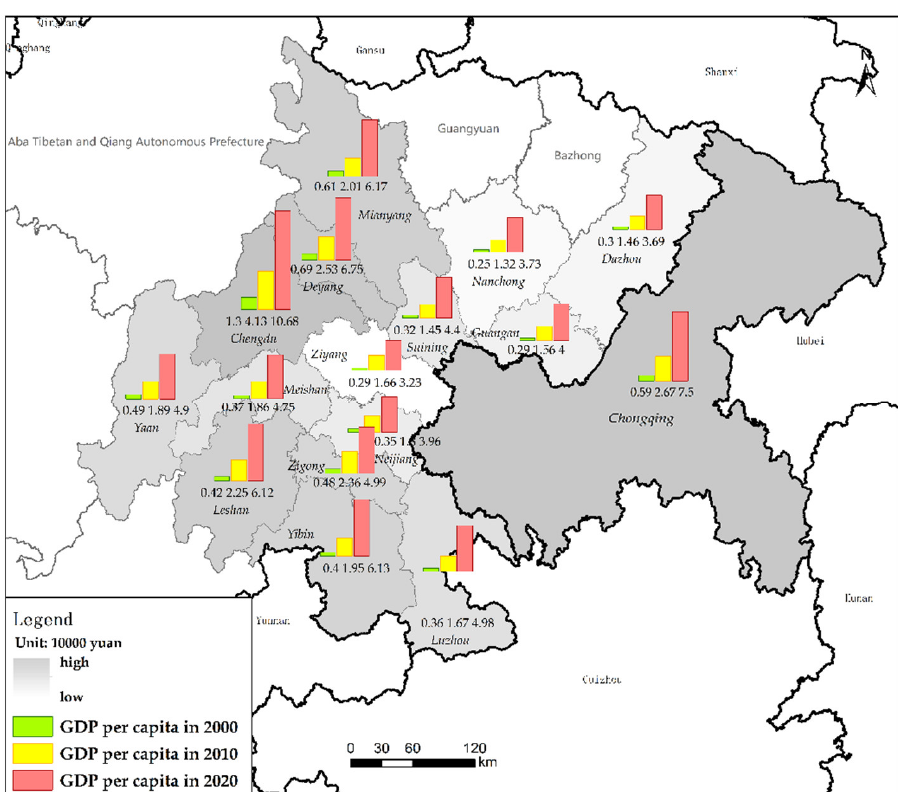
Figure 11. Changes in the per-capita GDP from 2000 to 2020. Table 2. Per-capita GDP and statistics for the 16 cities based on the three-year average (2000, 2010, and 2020).